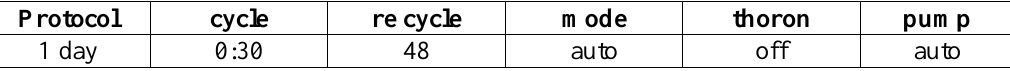
in all samples. Rn